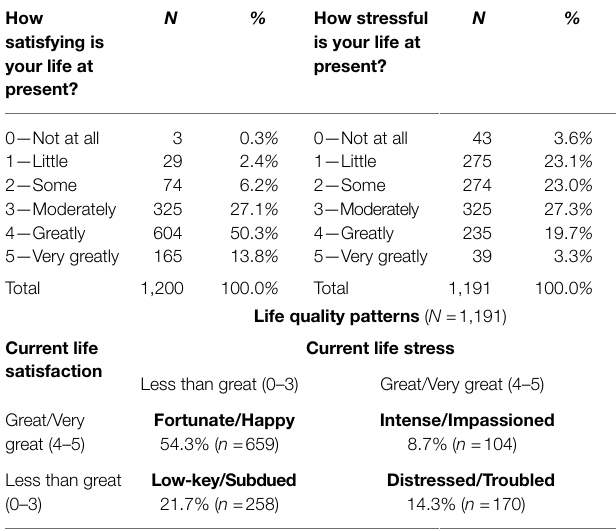
TABLE 3 | Trainees’ current life satisfaction, life stress, and life quality patterns. How satisfying